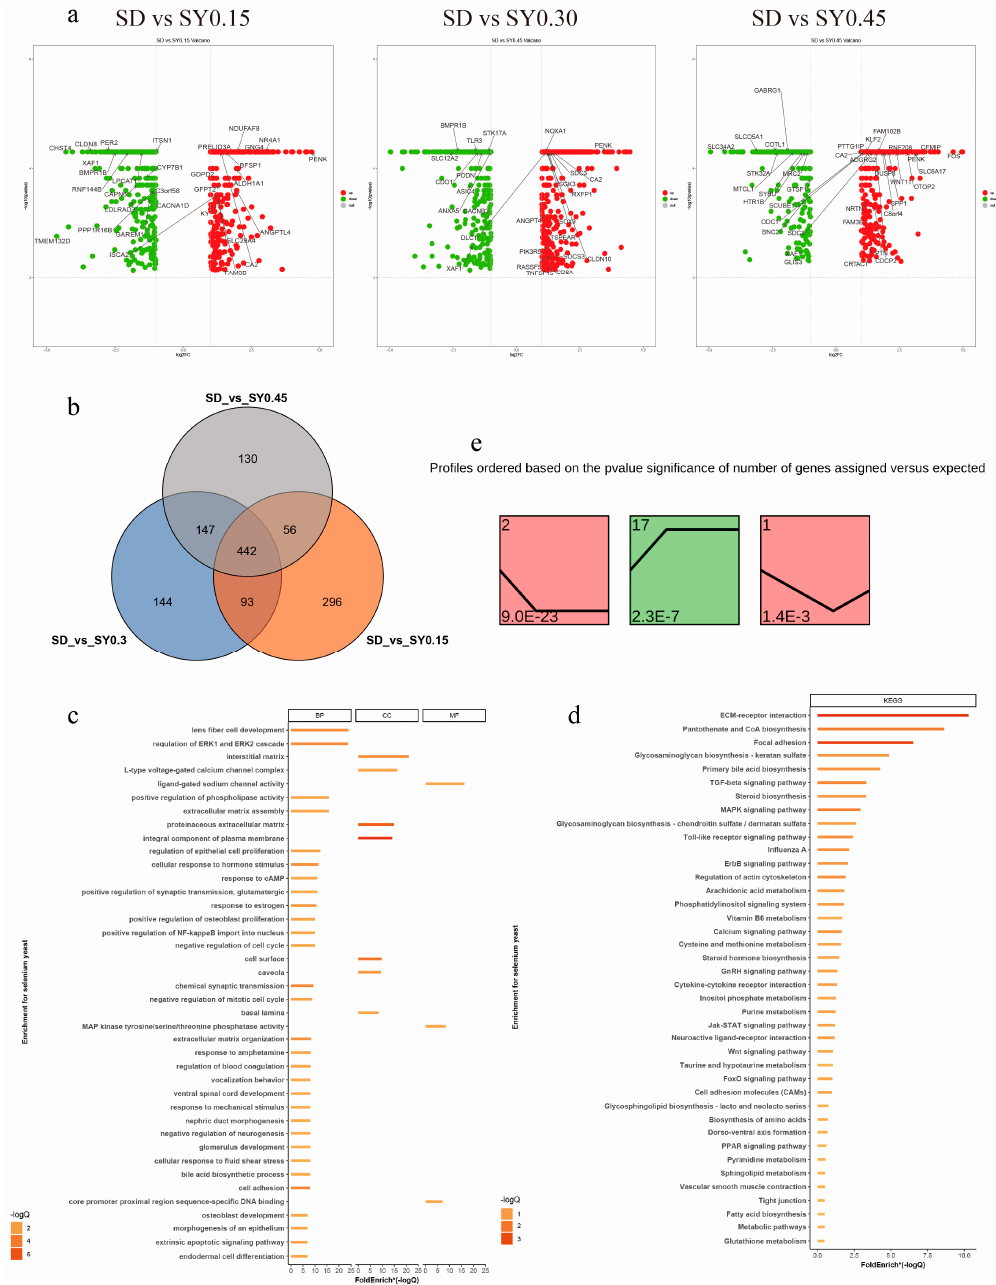
Figure 2. Transcriptome analysis revealed the effect on gene expression of shell gland in aged laying hens. ( a ) Scatter plots of DEGs (SD vs. SY0.15, SD vs. SY0.30, and SD vs. SY0.45). Red points represent upregulated genes with a log2 (fold change) > 1 and p < 0.05. Blue points represent downregulated genes with a log2 (fold change) < − 1 and p < 0.05. Gray points represent genes showing no significant difference. Fold change = normalized gene expression in the SY0.15, SY0.30, and SY0.45 group/normalized gene expression in the SD group. ( b ) Venn diagram showing the distribution of DEGs in three comparisons of Se supplementation. The number of DEGs is indicated in the diagram. ( c ) Gene Oncology enrichment analysis of DEGs identified among the three conditions (SD vs. SY0.15, SD vs. SY0.30, and SD vs. SY0.45). ( d ) KEGG pathway enrichment analysis of DEGs identified among the three conditions (SD vs. SY0.15, SD vs. SY0.30, and SD vs. SY0.45). ( e ) Identification of 3 significant gene cluster profiles by STEM. Colored block trend: significant enrichment trend ( p < 0.05). The number of genes in each significant cluster is shown after the cluster